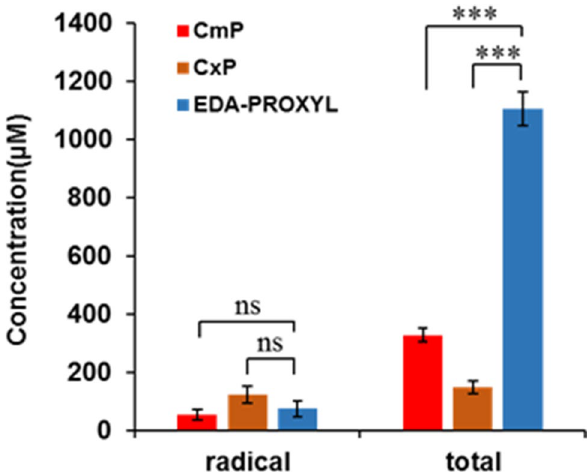
Figure 4. Analysis of the oxidised forms of carbamoyl PROXYL, carboxyl PROXYL, and EDA-PROXYL and total (oxidized plus reduced form) of each probe in the liver at 15 min after administration. The electron paramagnetic resonance signal intensity of probes in the liver homogenates were measured using X-band electron spin resonance (n = 5). Total amounts of each probe were measured after re-oxidation with potassium ferricyanide. Data are presented as mean ± standard deviation (n = 5 per group). * p < 0.05; *** p < 0.001; ns, not significant.